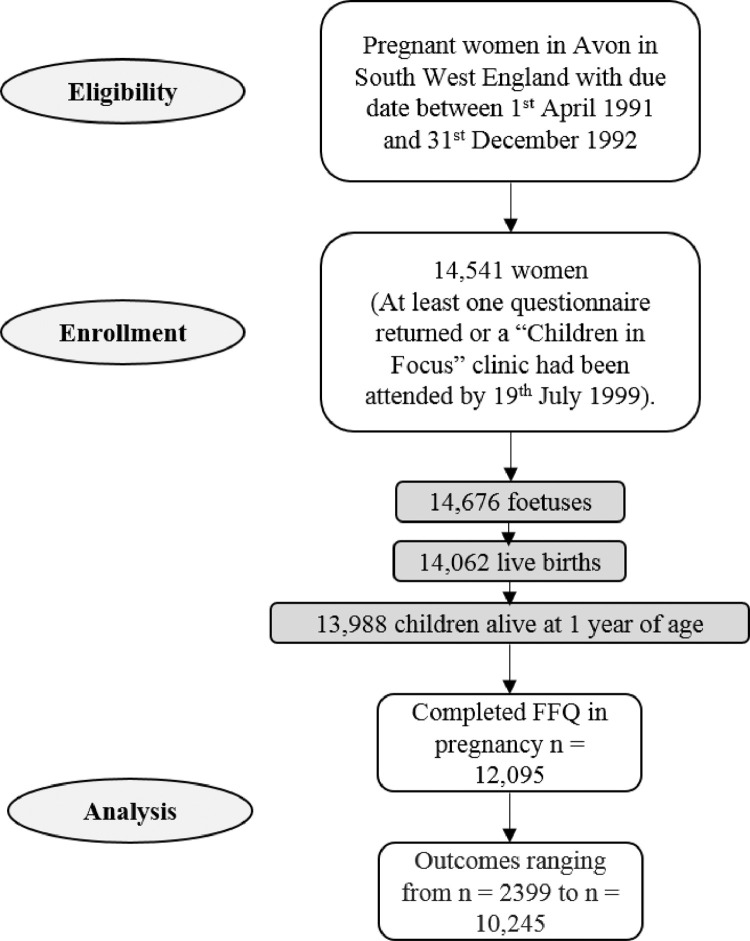
Number of participants included at each stage of the study.